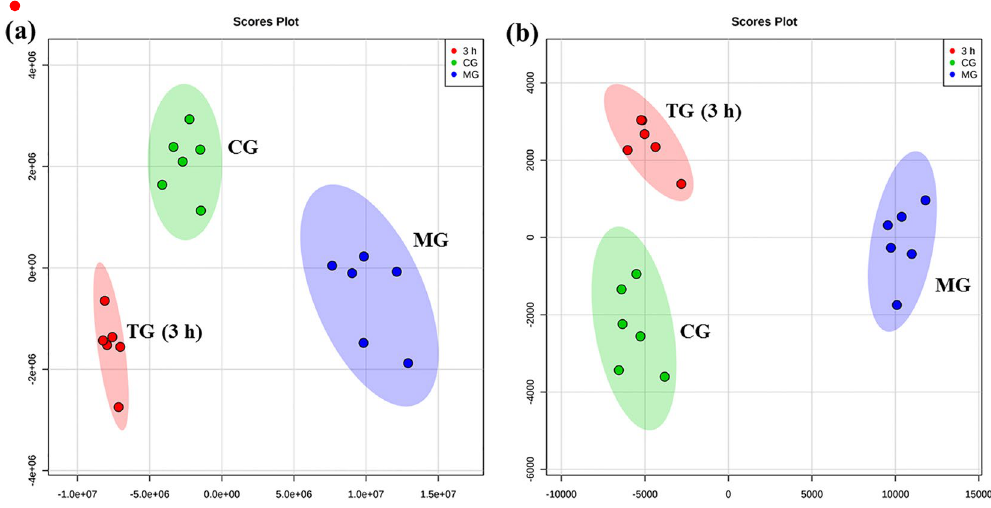
Figure 4. PLS-DA score plot obtained from CG ( ), MG ( ), and TG at 3 h ( ). ( a ) At positive ion mode. ( b ) At negative ion mode.